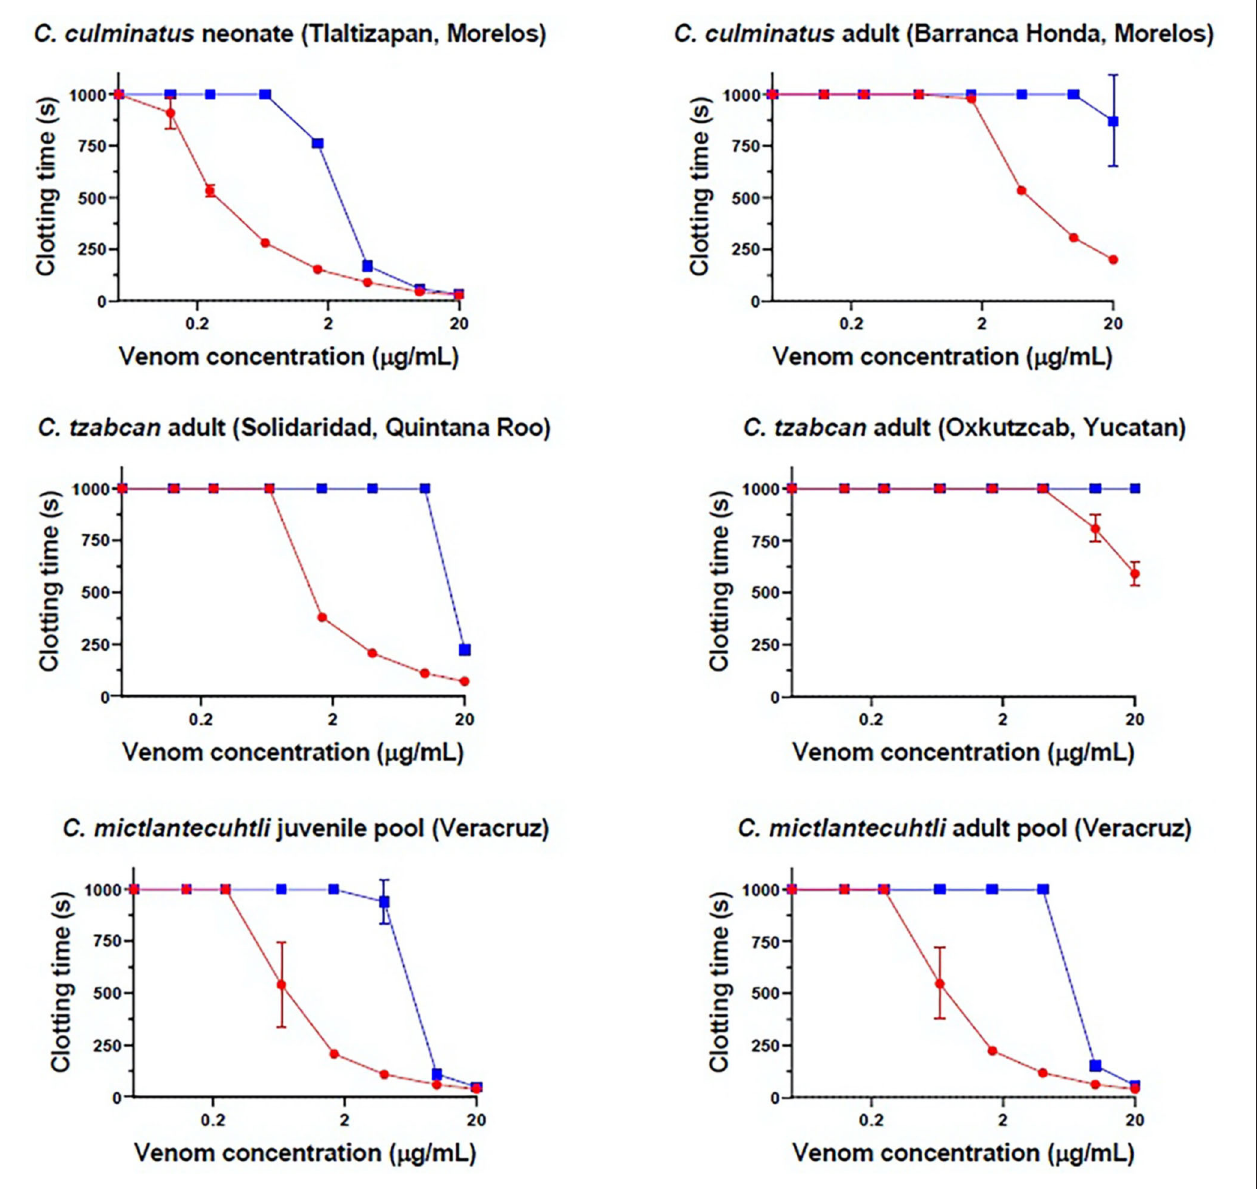
FIGURE 2 | Eight-point dilution curves for six representative venoms against Antivipmyn ® antivenom (2.5%) on human fibrinogen, Red = venom only, blue = venom + antivenom. X-axis is displayed in log form. Negative control = 999 + / − 0s.